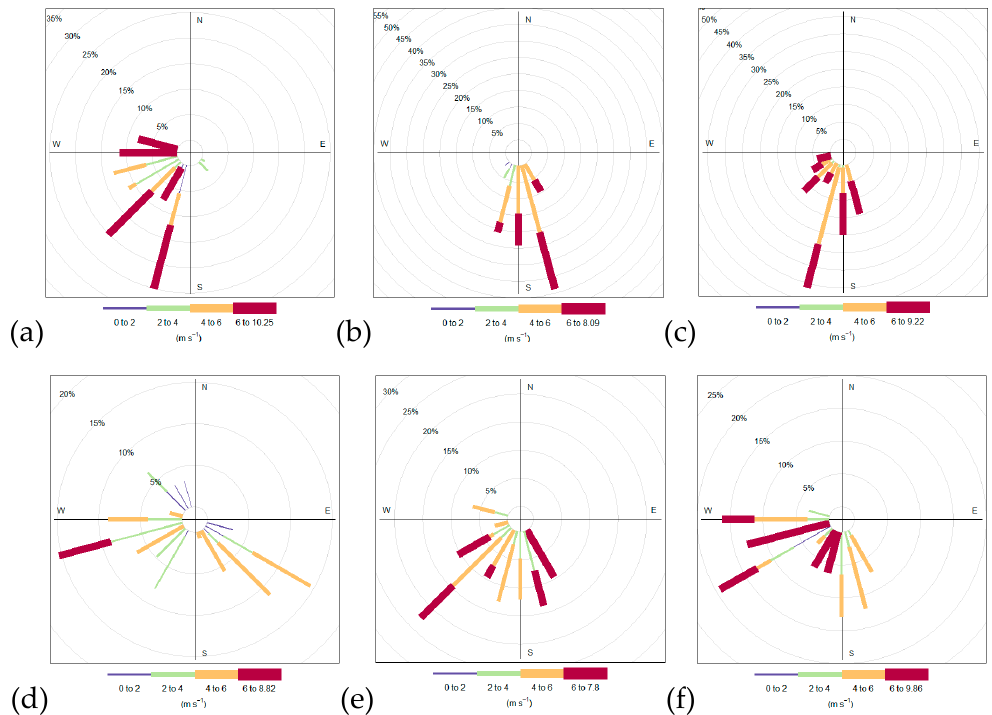
Figure 5. Wind roses during analysis period. (Locations of W1–W6 are shown in subfigures ( a )–( f ), respectively; direction indicates wind blowing from).